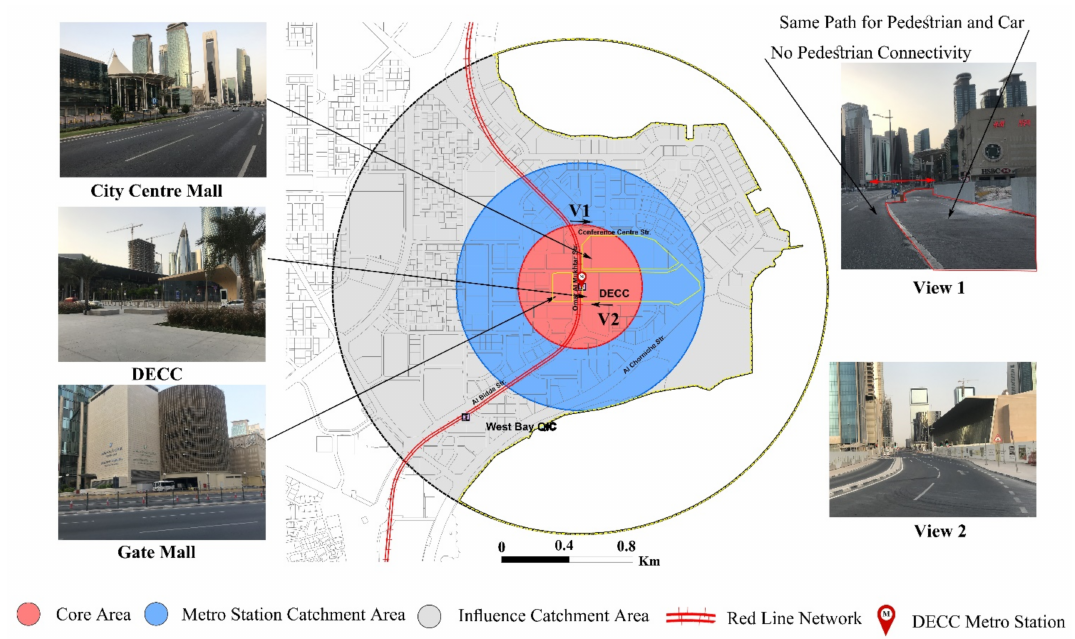
Figure 8. Defining the context of the DECC metro station